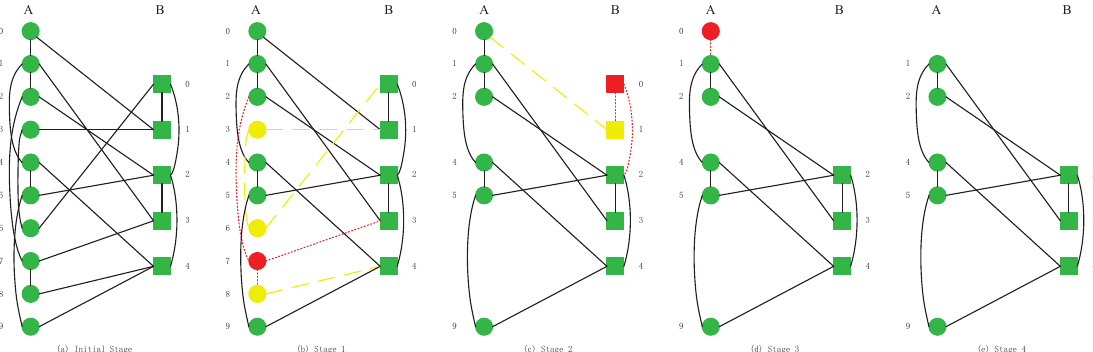
Figure 2. The cascading failure in interdependent